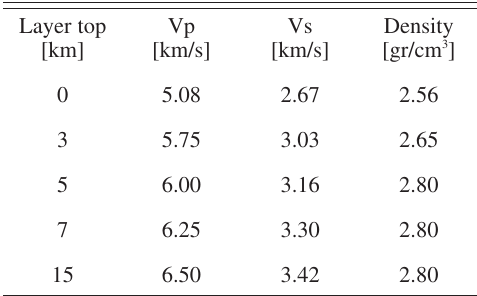
Table II. Crustal velocity model used in this simula- tion